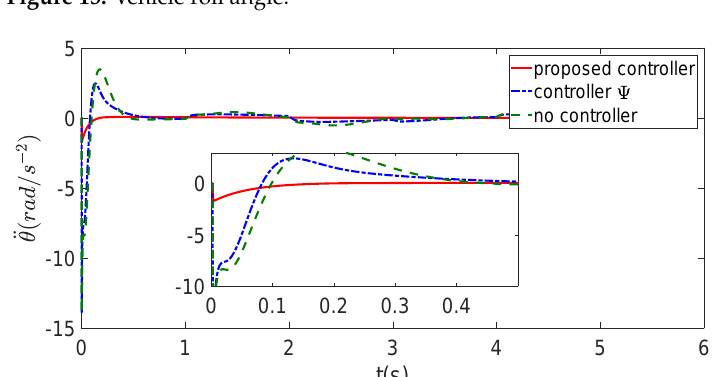
Figure 16. Vehicle roll angular